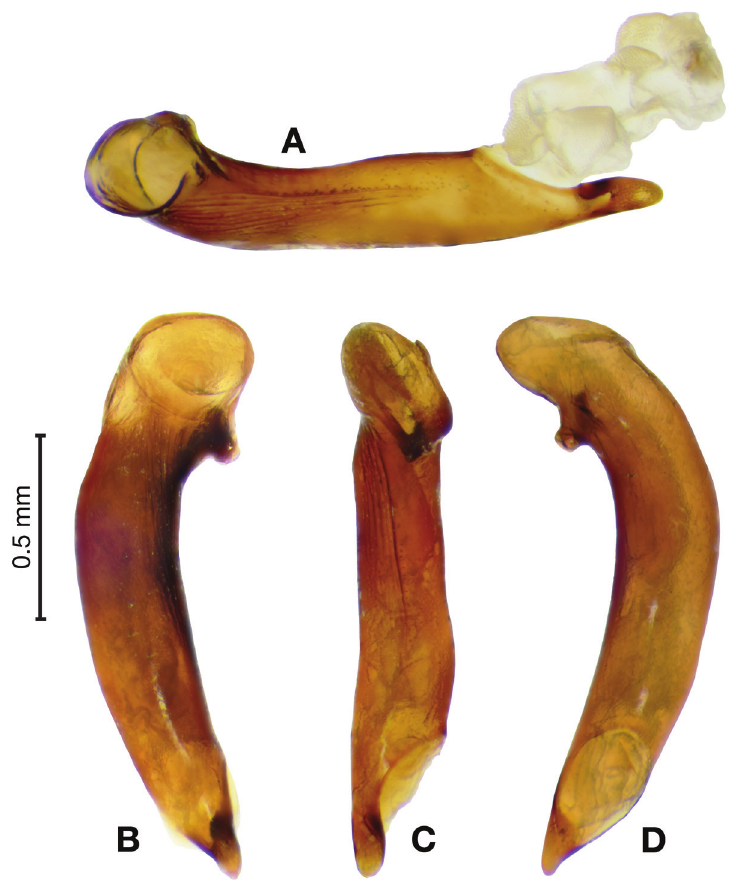
Figure 3. Digital images of male genitalia of Amphimenes asahinai Nakane. A ventral aspect, endophallus everted B right lateral aspect C ventral aspect D left lateral